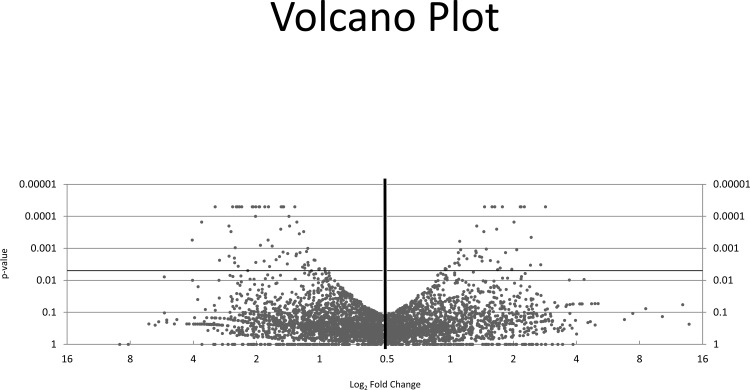
Volcano plot of log2 fold change vs statistical significance.